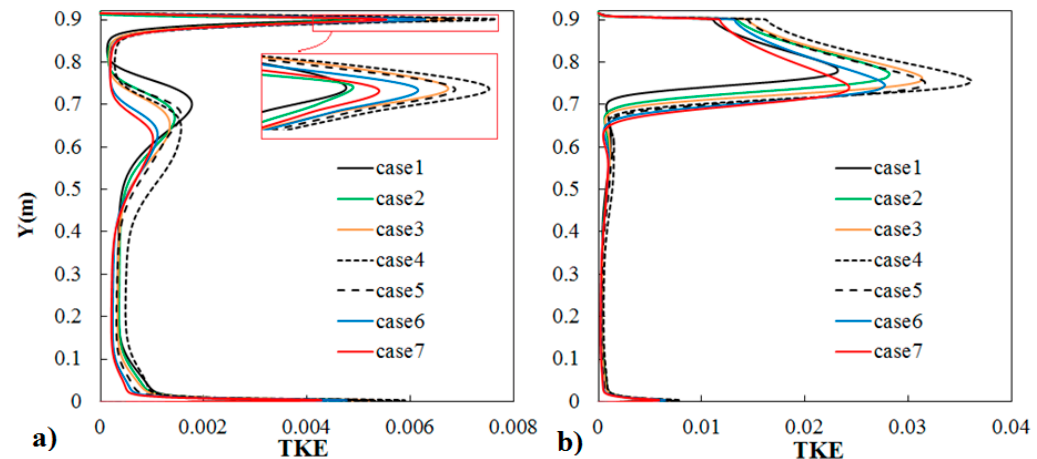
Figure 12. Transverse distribution of turbulent kinetic energy (TKE) at ( a ) x = Wc and ( b ) x = 1.5 Wc.